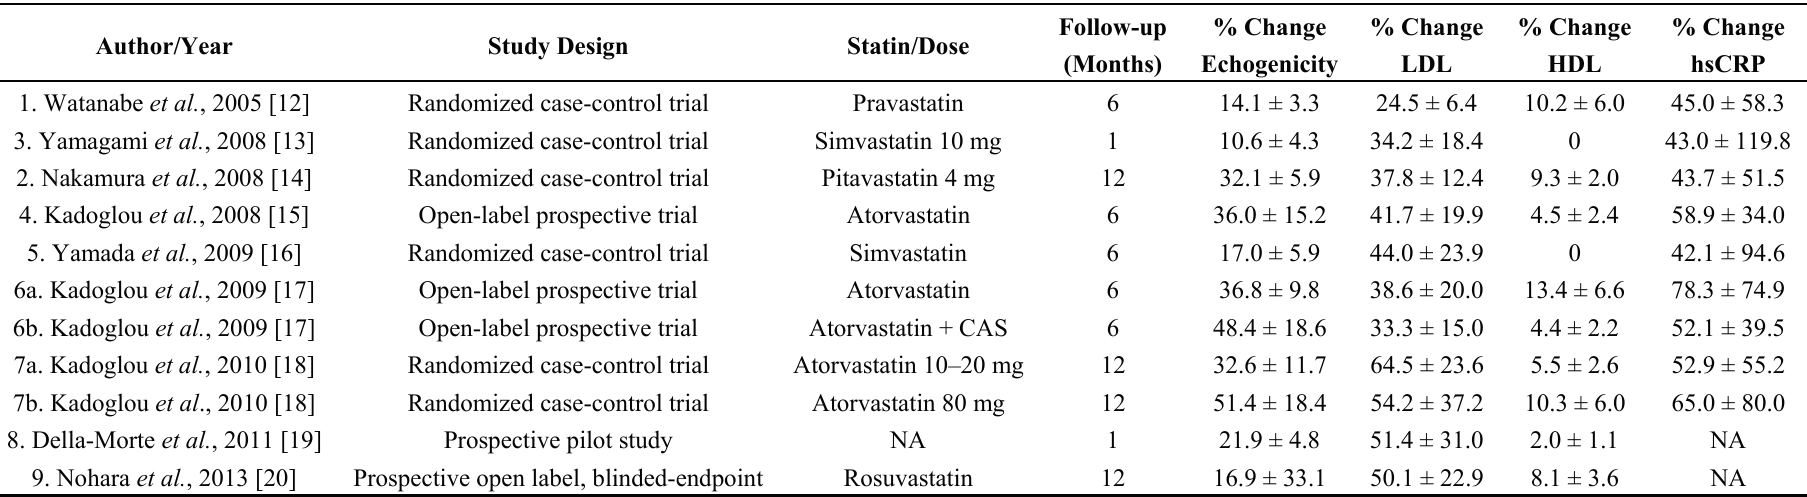
Table 2. Studies characteristics and statins effect on plaque echogenicity and LDL, HDL and hsCRP level on the